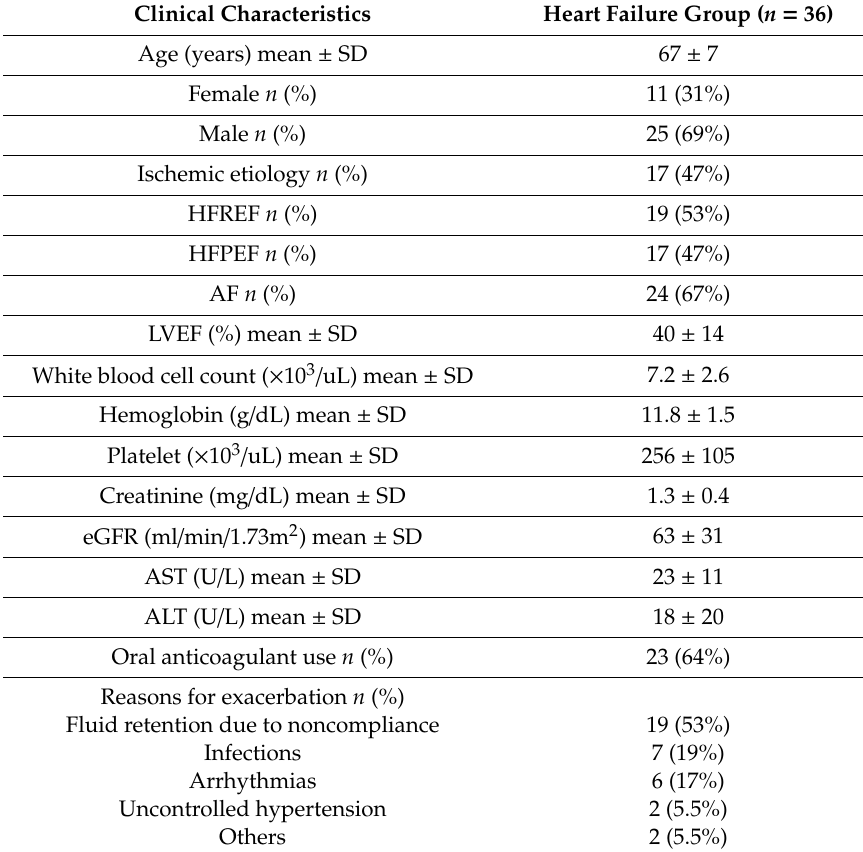
Table 1. Baseline clinical and laboratory parameters of heart failure patients.